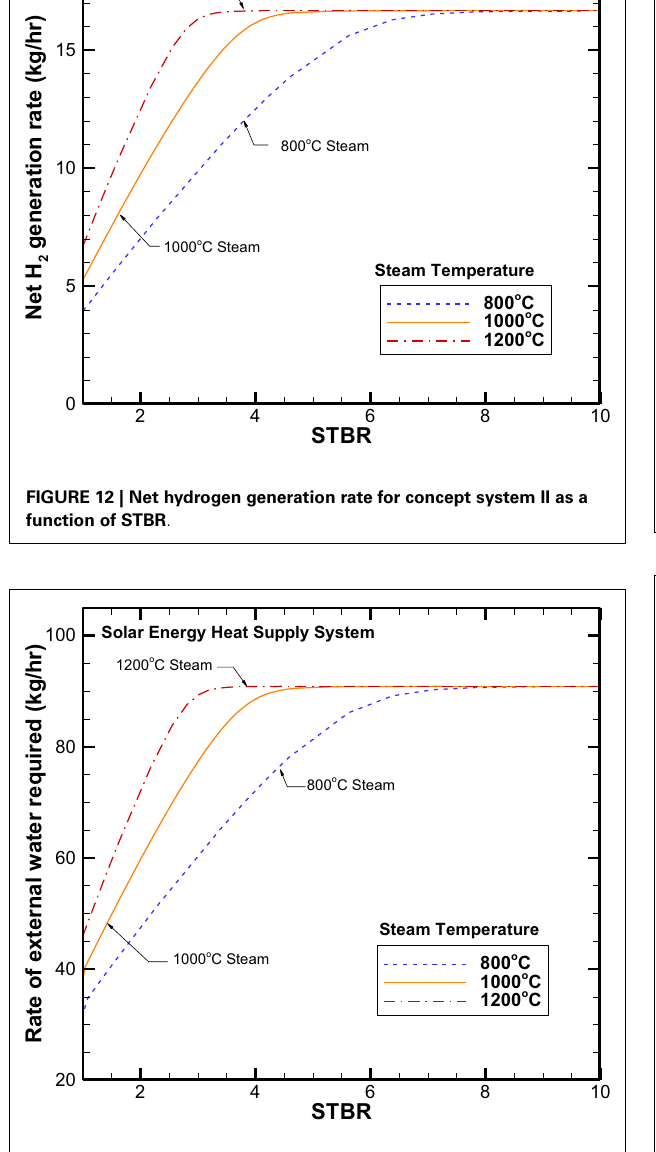
FIGURE 13 | Rate of external water required for concept system II as a function of STBR .